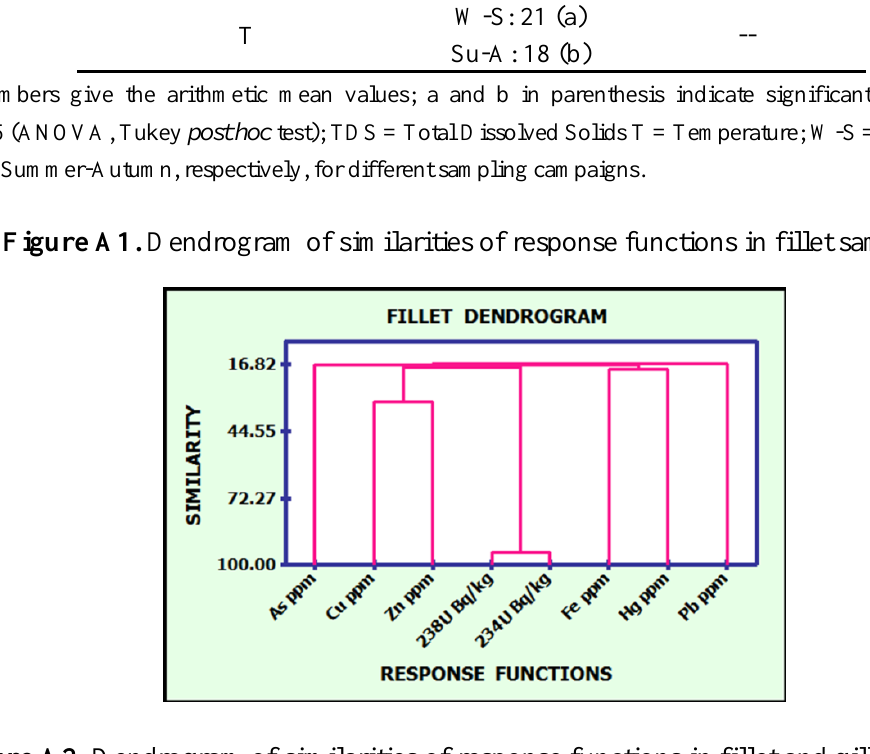
Figure A2. Dendrogram of similarities of response functions in fillet and gills